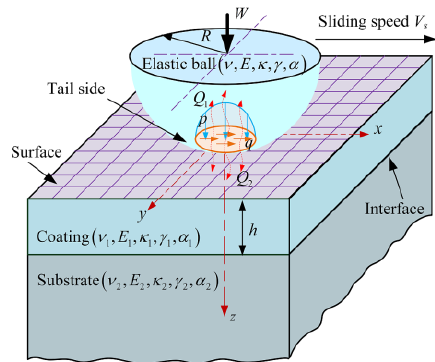
Figure 1. Description of the thermoelastic contact between an elastic ball and a half space coated with a homogeneous coating considering the frictional heat partition.